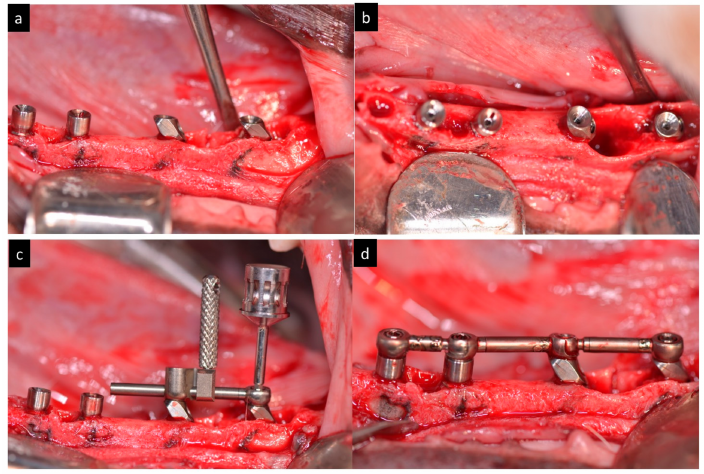
Figure 5. ( a ) Lateral view of abutments connected to the implants. ( b ) Oclusal view of abutments connected to the implants. ( c ) Screwing of the bar. ( d ) Clinical aspect of the bar framework screwed in the